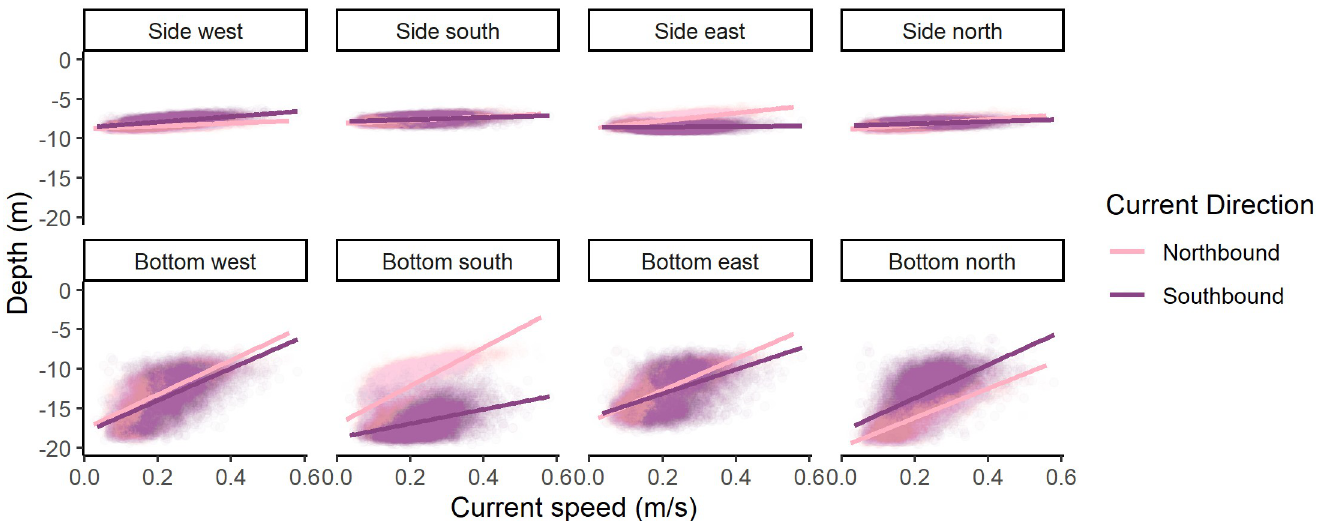
Fig 5. Depth measured by pressure sensors. Depth measured by pressure sensors located at the bottom of the side net (Side- west, south, east, and north) and half way from the side to the centre (Bottom- west, south, east, and north). Points are depths measured and lines are lines of best fit. Darker points and lines are depths in southbound current and light points and lines are depths in northbound